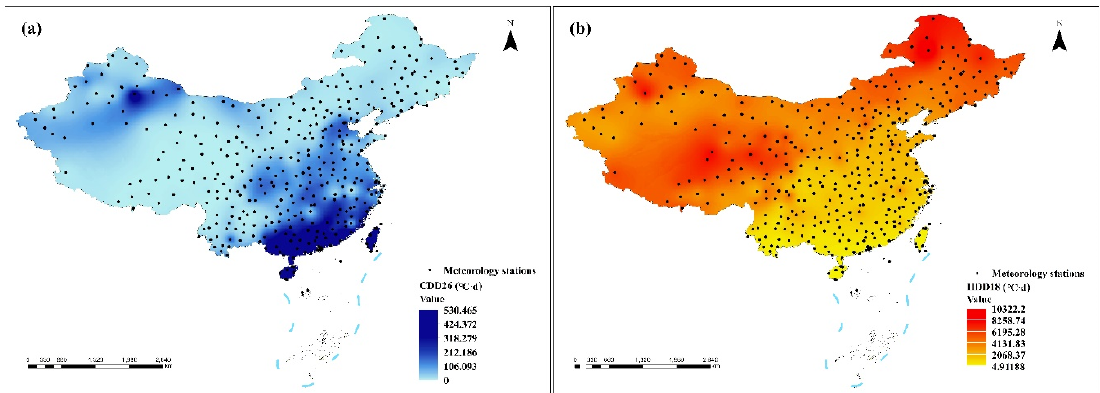
Figure 2. Distribution of CDD ( a ) and HDD ( b ). The darker the color, the higher the demand for cooling or heating.